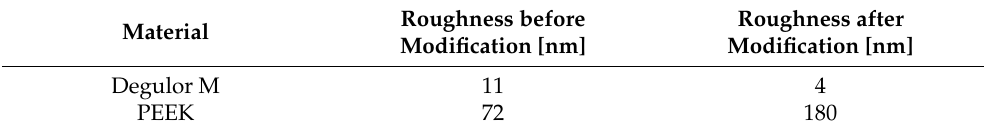
Table 1. Comparison of roughness before and after